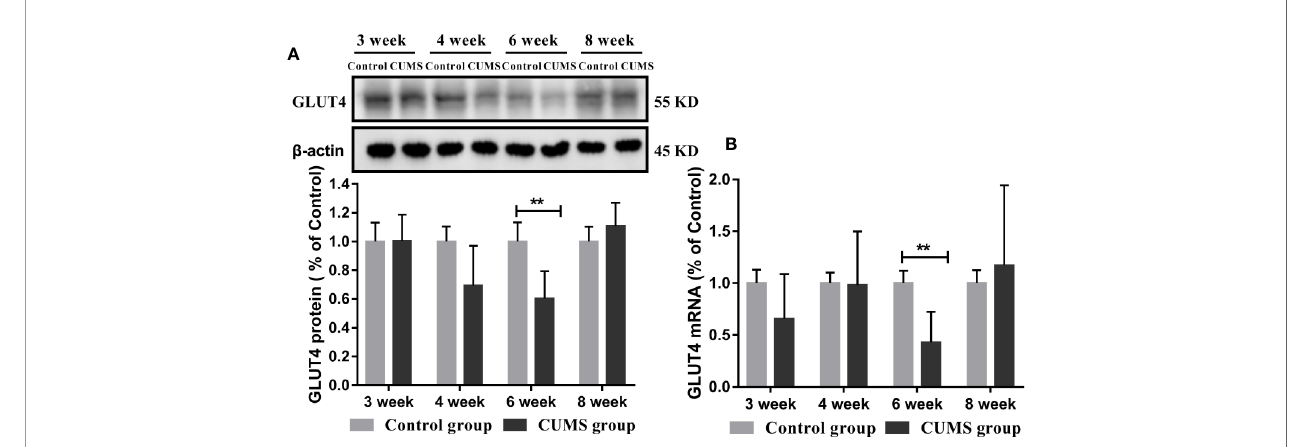
FIGURE 6 | Effect of CUMS exposure on expression of GLUT4 in the hypothalamus of rats. (A) Protein levels of GLUT4 by western blot, the representative images for immunoblots are shown in the top panels, and quantitative data are shown in the bottom panels. (B) mRNA levels of GLUT4 by RT-qPCR. Data are presented as mean ± SD, n = 6; **p < 0.01 vs. Control group.